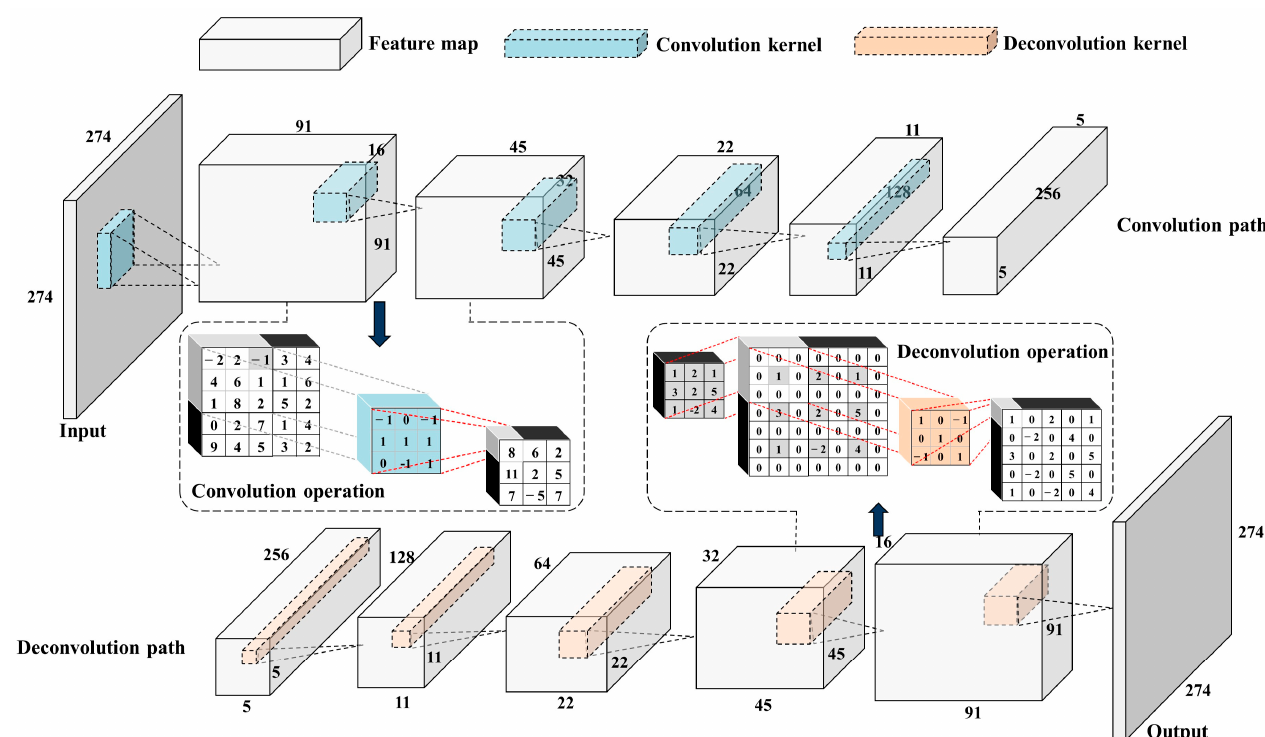
Figure 2. The detailed structure of the proposed reduced-order model based on the neural